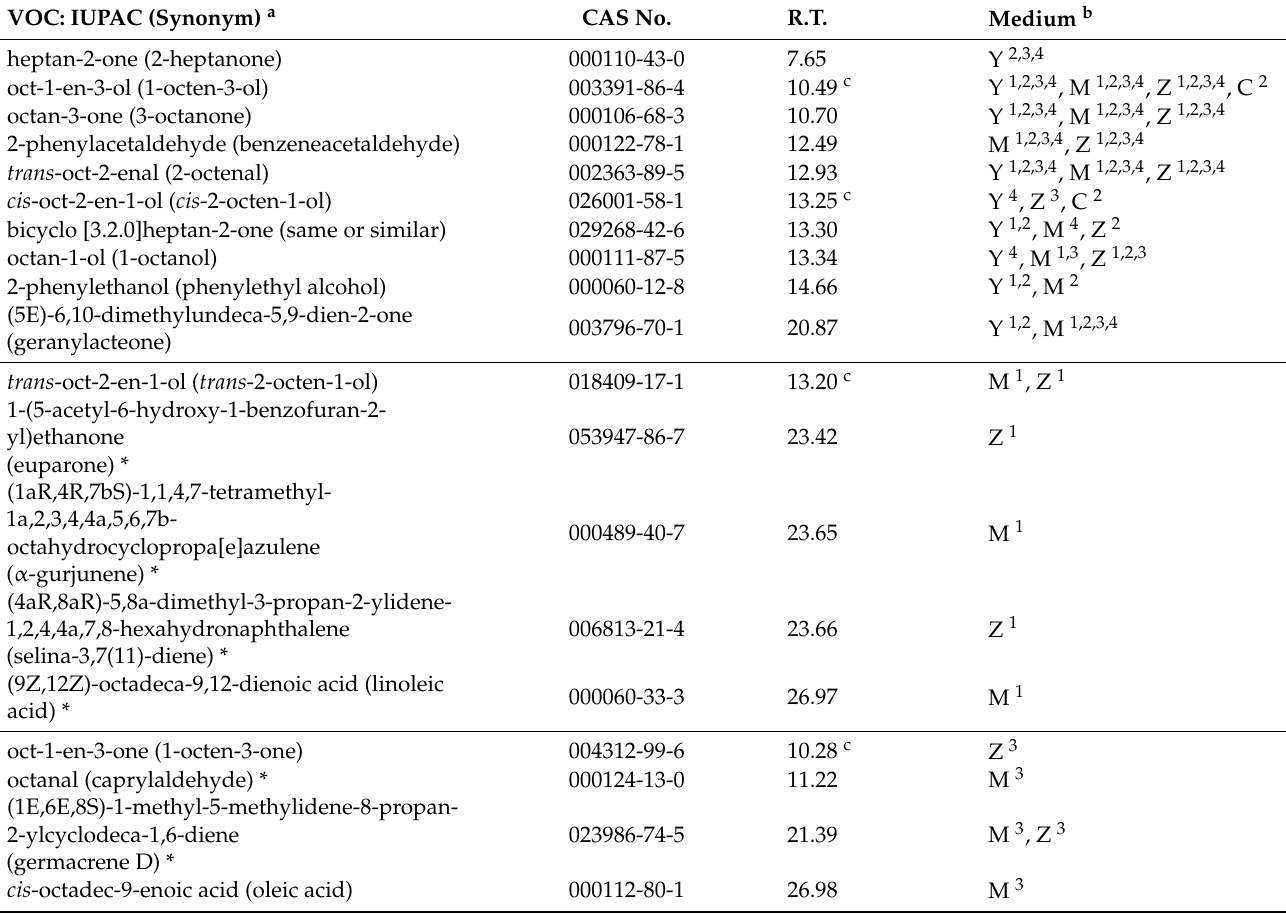
Table 1. Headspace VOC profiles for multiple Aspergillus strains while growing on different synthetic media for one